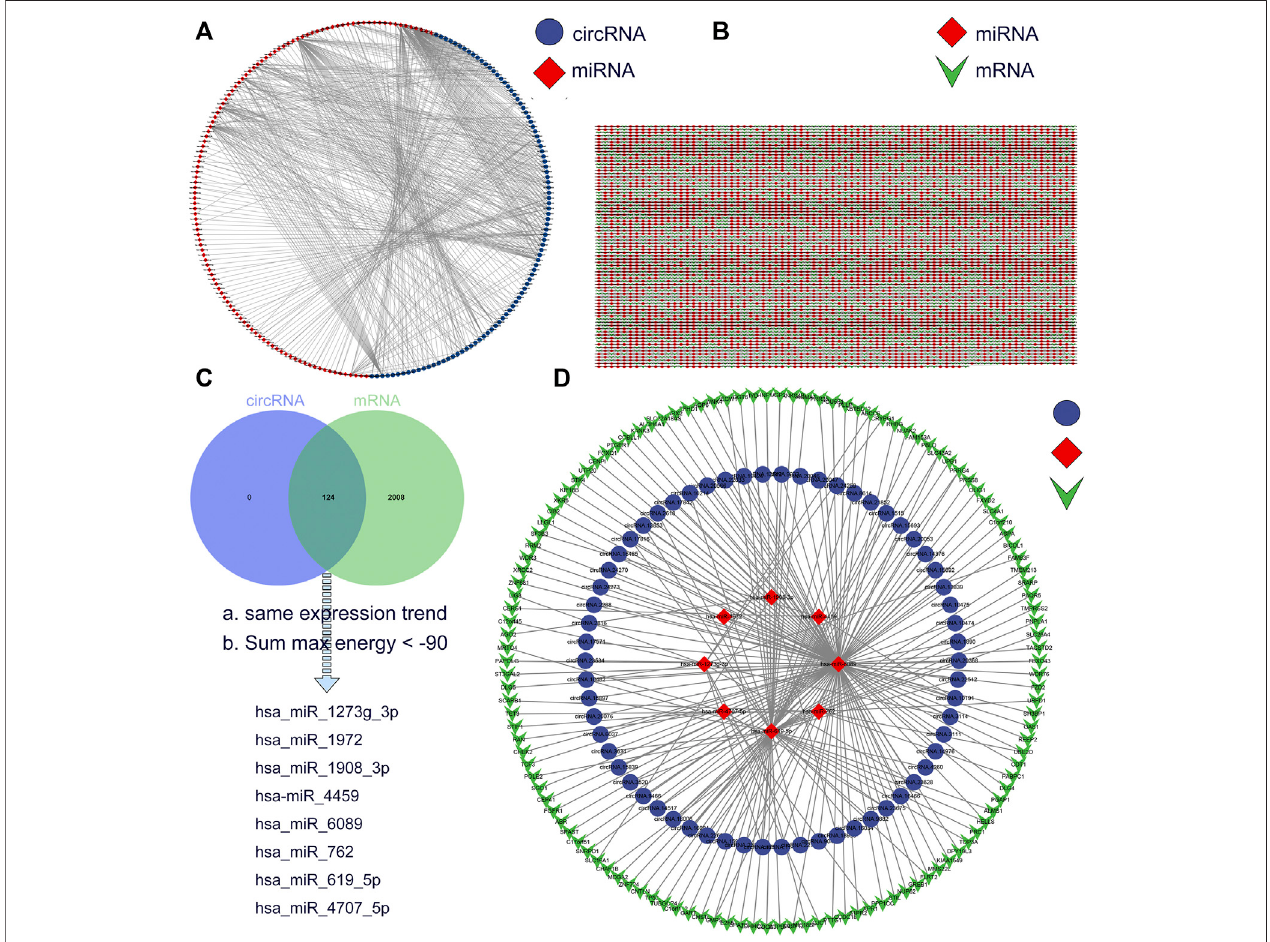
FIGURE5| ConstructionofacircRNA-miRNA-mRNAceRNAnetworkinWilmstumor. (A) circRNA-miRNAregulatorynetwork.BluecirclesrepresentcircRNAand red rhombi represent miRNA. (B) miRNA-mRNA regulatory network. Red rhombi represent miRNA and green triangles represent mRNA. (C) The intersection of miRNA targetbetweenDE-circRs andDE-mRs. (D) TheceRNAregulatorynetwork.Bluecirclesrepresent circRNA, redrhombirepresent miRNA,andgreentriangles represent mRNA.